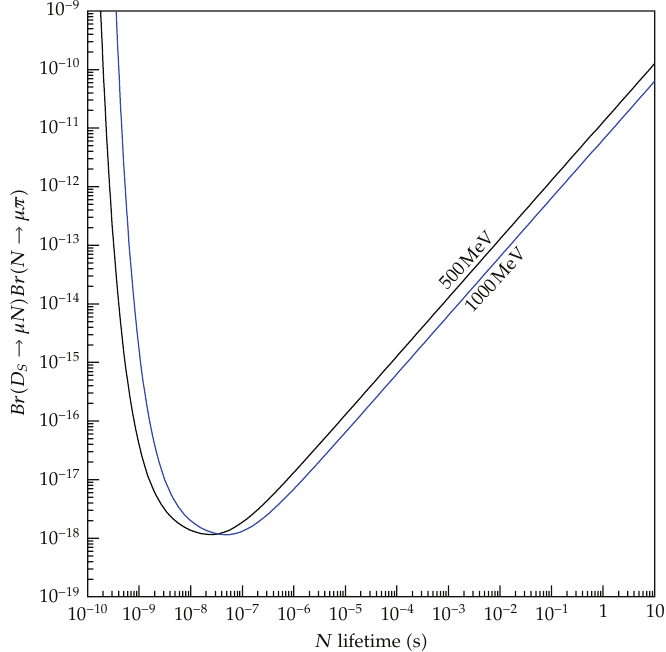
Figure 10: The expected 90% C.L. upper limits on the branching ratio Br (cid:2) D s → μN (cid:3) Br (cid:2) N → μπ (cid:3) versus τ N estimated for the proposed experiment in the background free case. The numbers near the curves indicate the corresponding values of sterile neutrino